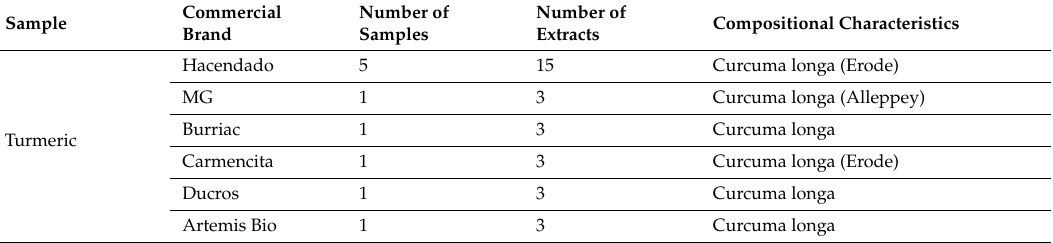
Table 2. Characteristics of the analyzed turmeric and curry